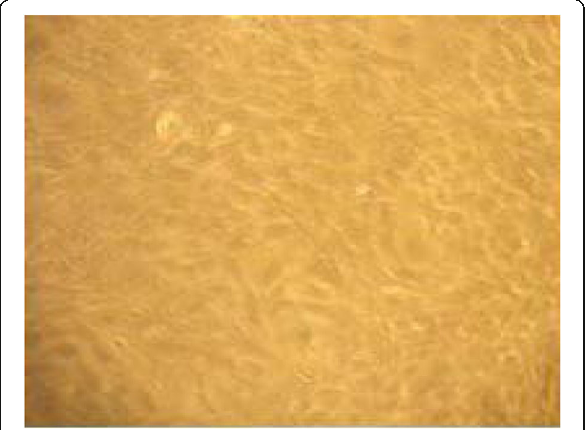
Fig. 4 Sensitivity of 4TI cancer cells to purple tea at IC 50 of 29.27 μ g/ml showing disruption of